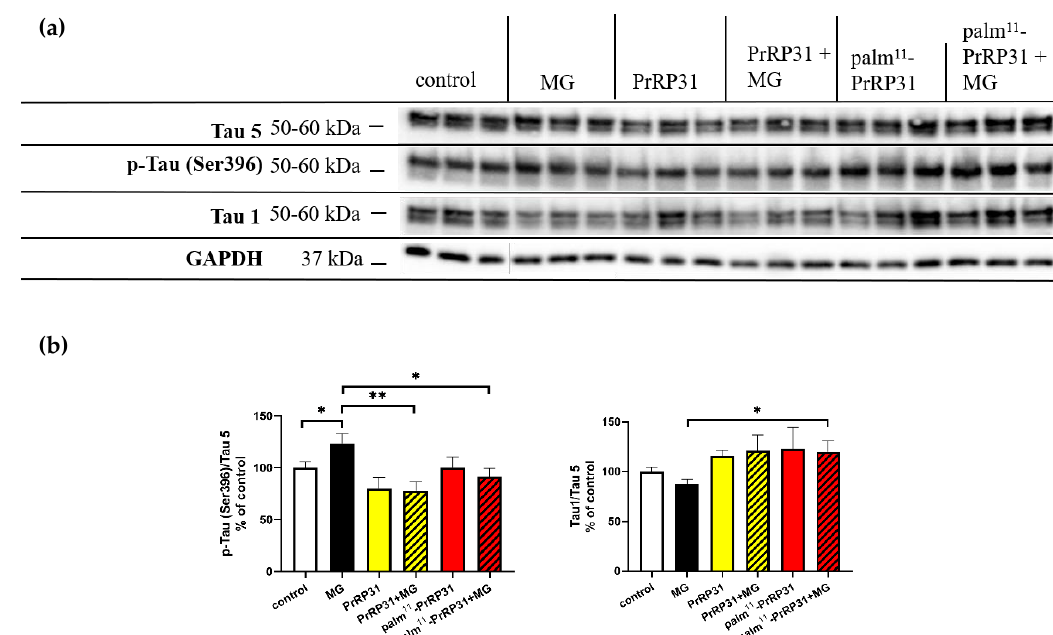
Figure 8. PrRP31 and palm 11 -PrRP31 attenuate Tau hyperphosphorylation at the epitope Ser396 in SH-SY5Y. Immunoblots with: ( a ) and their quantifications: ( b ). SH-SY5Y cells were pretreated with PrRP31 and palm 11 -PrRP31 at a concentration of 1 × 10 − 5 M for 4 h and then stressed with 0.6 mM MG for 16 h. Activation was expressed as the ratio of the activated protein to the total amount of the protein, both normalized to loading control, GAPDH. Data are presented as the means ± SEM as a percentage of control cells treated with medium alone. Analysis is made vs. MG by a Student’s t -test, * p < 0.5, ** p < 0.01 (each sample replicate in triplicate).